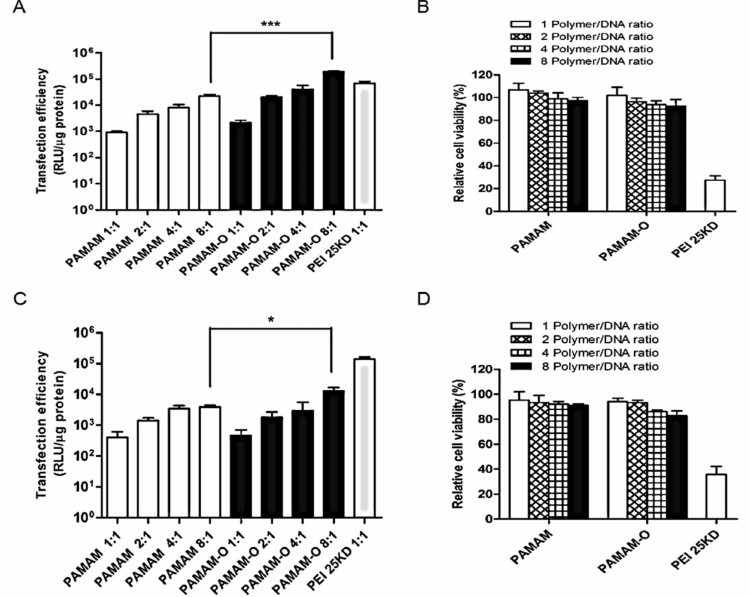
Figure 4. Transfection efficiency of the PAMAM-O dendrimer. ( A ) HepG2 cells were transfected with pJDK/Luc polyplexed with PAMAM and PAMAM-O dendrimers at different weight ratios (1, 2, 4, and 8). Luciferase activity was measured using Lumat LB 9507, and PEI25KD was used as a positive control. Data represent the mean ± standard deviation ( n = 3) of three independent experiments. Asterisks show statistical significance. Unpaired t -test: *** p < 0.001; ( B ) Cells were treated at the same conditions as in panel A, and cell viability was measured by the WST assay. Data represent the mean ± standard deviation ( n = 3) of three independent experiments; ( C ) Dermal fibroblasts were transfected at the same conditions as in panel A. Data represent mean ± standard deviation ( n = 3) of three independent experiments. Asterisks show statistical significance. Unpaired t -test: * p < 0.05; ( D ) Cells were treated at the same conditions as in panel C, and cell viability was measured by the WST assay. Data represent the mean ± standard deviation ( n = 3) of three independent